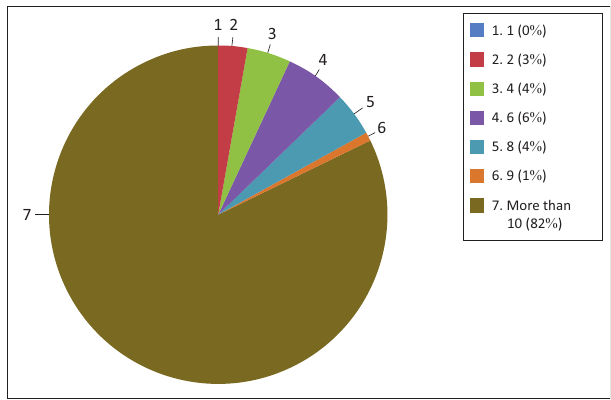
FIGURE 3: Number of books that were read per